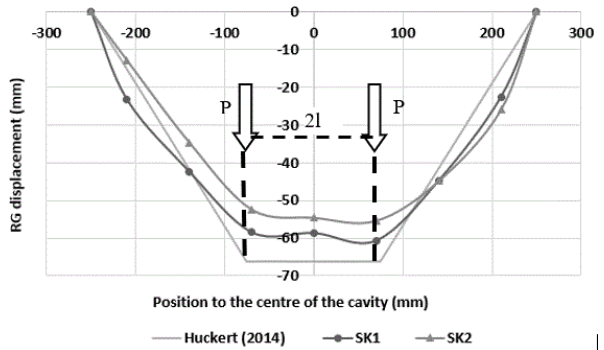
Figure 14. Evolution of the RG displacements after the collapse of the cohesive soil